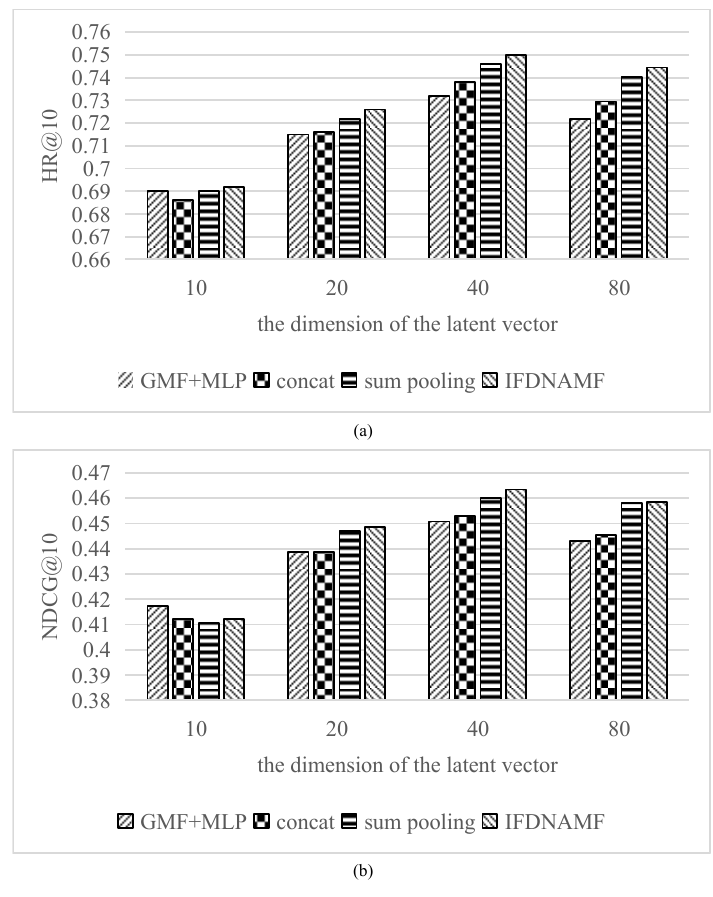
Figure 2. The HR@10 and NDCG@10 of models with different potential vector dimension on MovieLens. ( a ) HR@10. ( b )